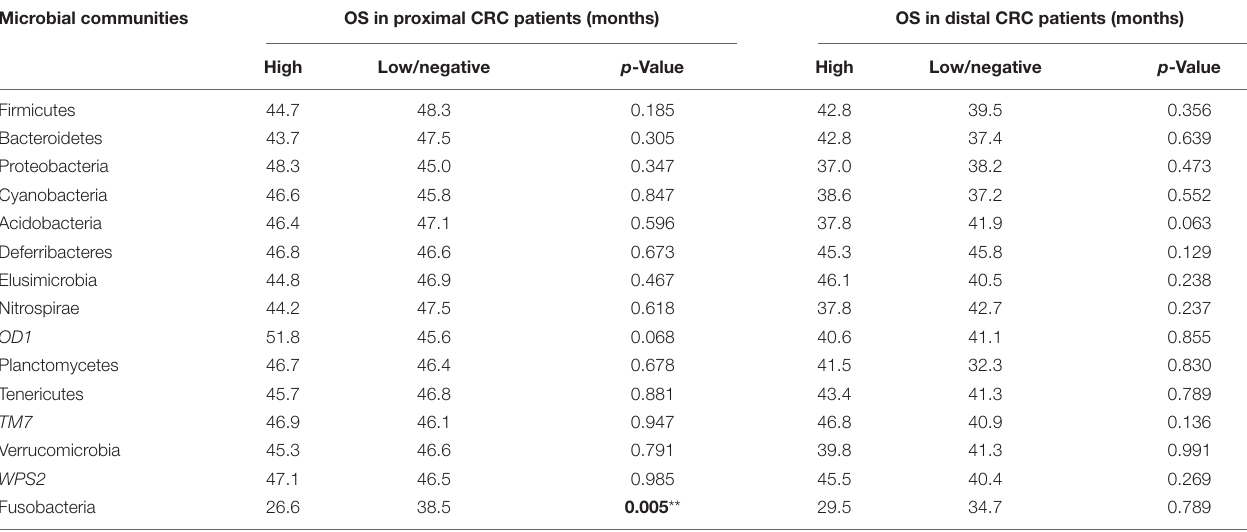
FIGURE 4 | Association of Fusobacteria enriched in proximal tumor tissues with clinical overall survival. The Kaplan–Meier curves for colorectal cancer overall survival according to the relative status of Fusobacteria in CRC tumor tissues (A) , the relative status of Fusobacteria in proximal tumor tissues (B) , and the relative status of Fusobacteria in distal tumor tissues (C) . Cases with Fusobacteria were categorized as high or low/negative using the medium value as cutoff point. The p -value was calculated by the log-rank test. CRC, colorectal cancer. TABLE 5 | Association of microbial communities with overall survival of proximal and distal